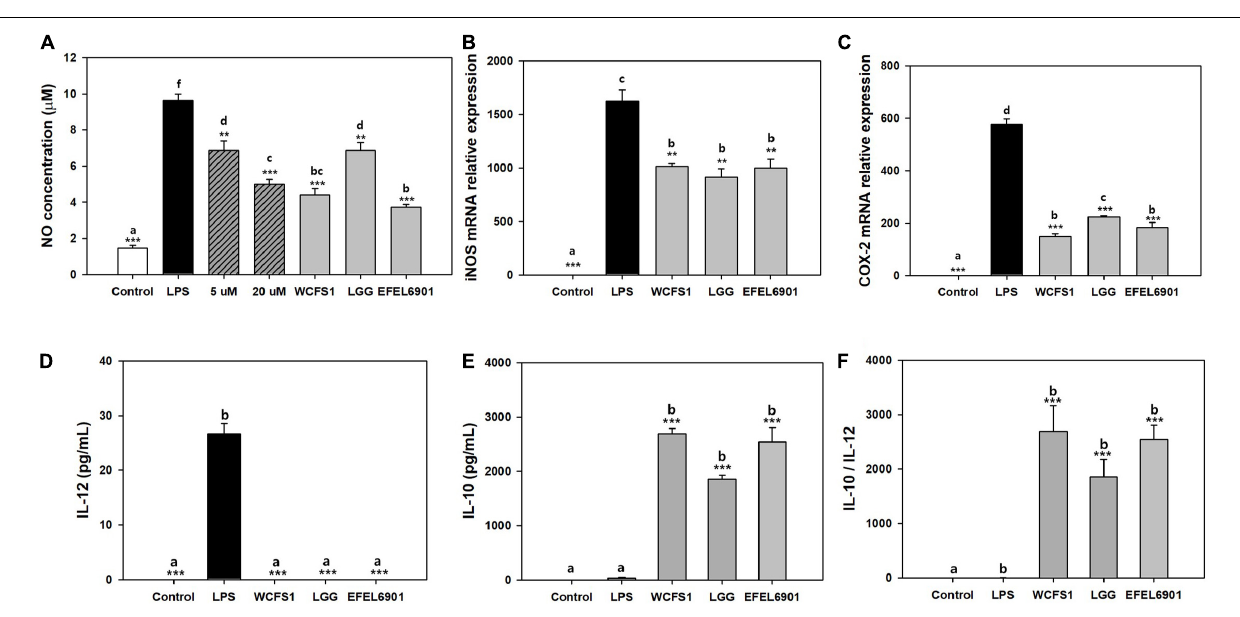
FIGURE 3 | Anti-inflammatory effect of Limosilactobacillus reuteri EFEL6901 in LPS-induced RAW 264.7 cells (A–C) and LPS-induced mouse peritoneal macrophage cells (D–F) . Effects of heat-killed L. reuteri EFEL6901 on the production of NO (A) , mRNA expression of iNOS (B) and COX-2 (C) in LPS-induced RAW 264.7 cells were measured after 24 h. Expressed mRNA levels of iNOS and COX-2 were determined by real-time PCR. Effects of heat-killed Lactobacillus reuteri EFEL6901 strain on IL-12 (D) , IL-10 (E) and the calculated ratio IL-10/IL-12 (F) in LPS-induced mouse peritoneal macrophages. Cells were treated with heat-killed bacteria and stimulated with LPS for 24 h. The levels of IL-12 and IL-10 in cell culture supernatants were measured by ELISA kits. Different letters indicate a significant difference at p < 0.05 according to Duncan’s multiple range test. Significant differences are presented with LPS positive group: * p < 0.05; ** p < 0.01; *** p <